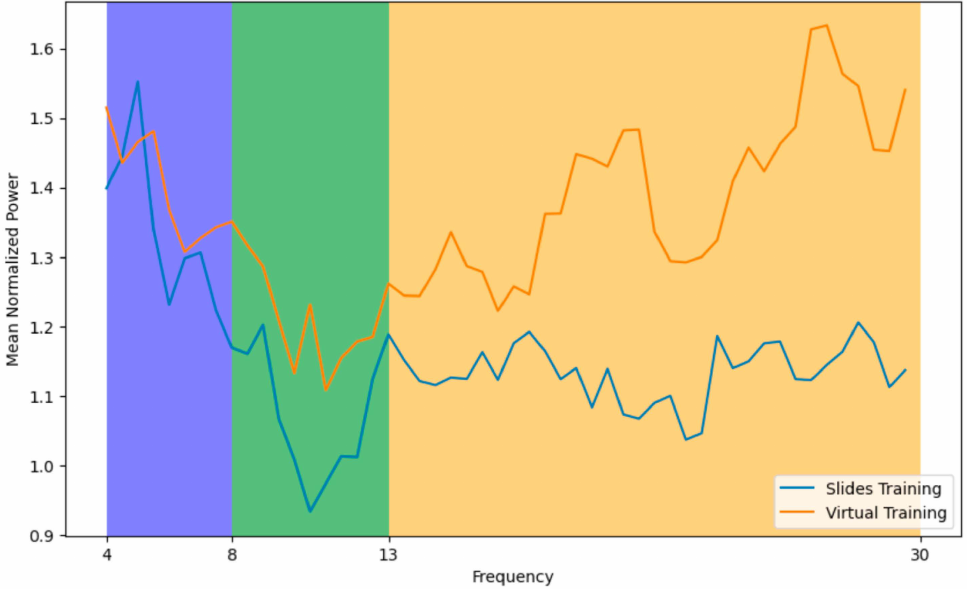
Figure 7. Mean normalized power in SBST and VSW on theta (violet), beta (green), and alpha (yellow) frequency